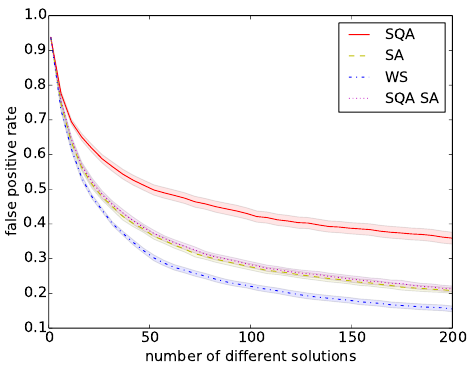
Figure 7: Average FPR of a filter constructed from solutions randomly chosen from the set of solutions found by each solver within 800 runs. The average is taken over 20 randomly generated 4-SAT instances with n = 50 variables and a clauses-to-variables-ratio of α χ For SQA SA, 10% of the solutions were chosen from the solutions found by SQA and 90% were chosen from the solutions found by